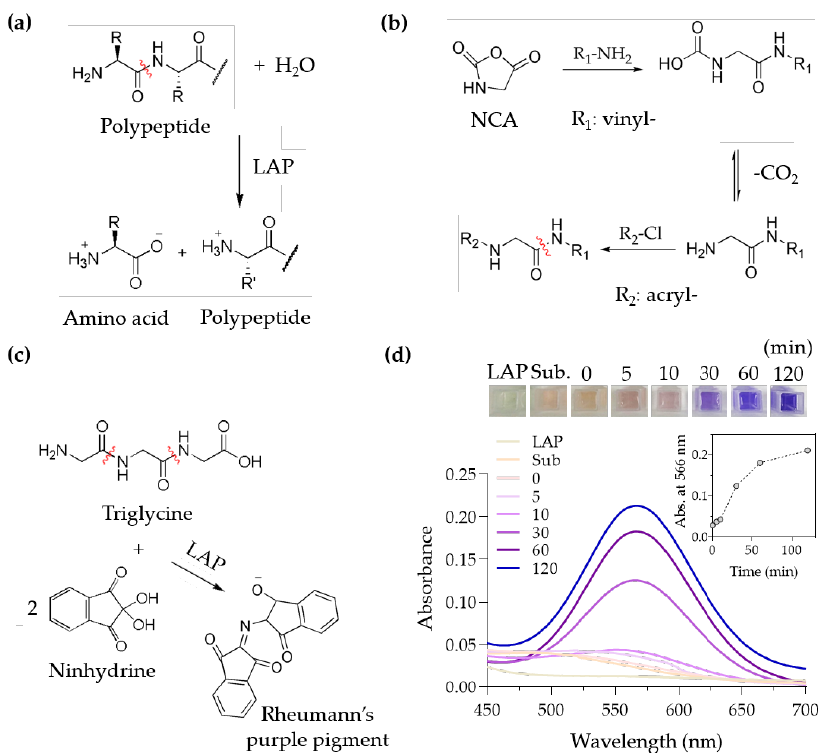
Figure 2. Synthesis of the end-modified LAP substrate and its biodegradability. ( a ) LAP catalyzes the hydrolysis of the amide bond at the N -terminus of a peptide. ( b ) Ring-opening polymerization of NCA is initiated by allylamine, and the N -terminus of the oligo (glycine) was modified with acryloyl chloride to become acrylamide. ( c ) When triglycine is cleaved by LAP, a primary amine is generated and reacts with ninhydrin to produce Rheumann’s purple pigment, which can be quantitatively measured using a spectroscopic method. ( d ) A photograph of purple pigments produced as a result of the triglycine cleavage by LAP at a varying incubation time ( top ) and the UV–Vis spectra ( bottom ) (inset: absorbance at 566 nm).